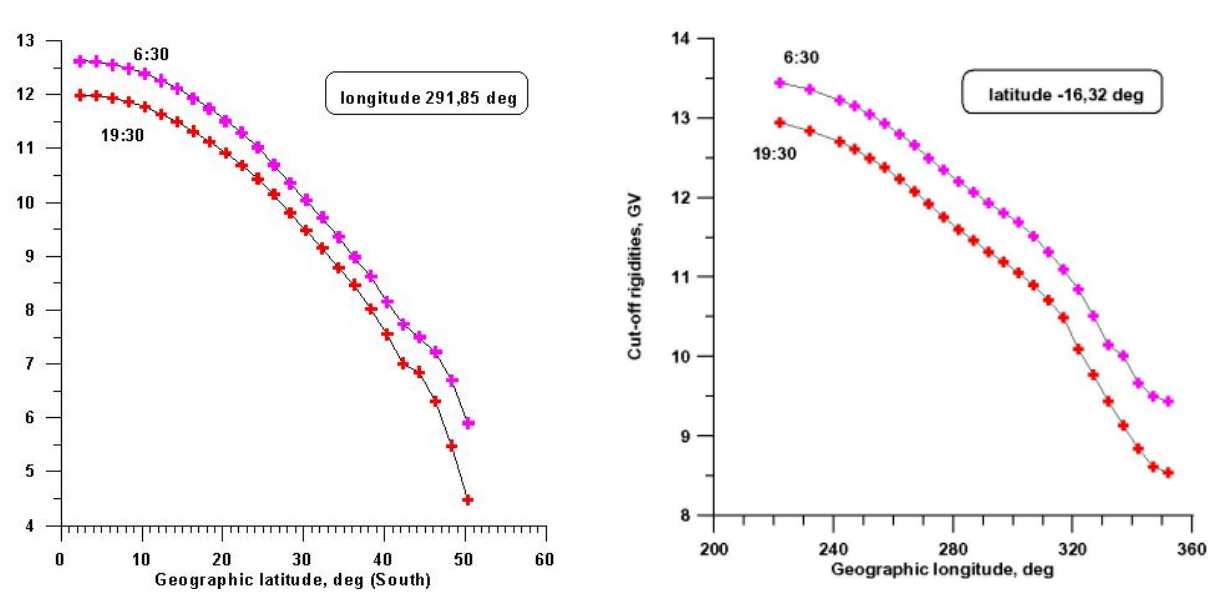
Fig. 5. The same as in Fig. 3 but for the Chacaltaya station. Figure 5. The same as in Figure 3 but for the Chacaltaya station.